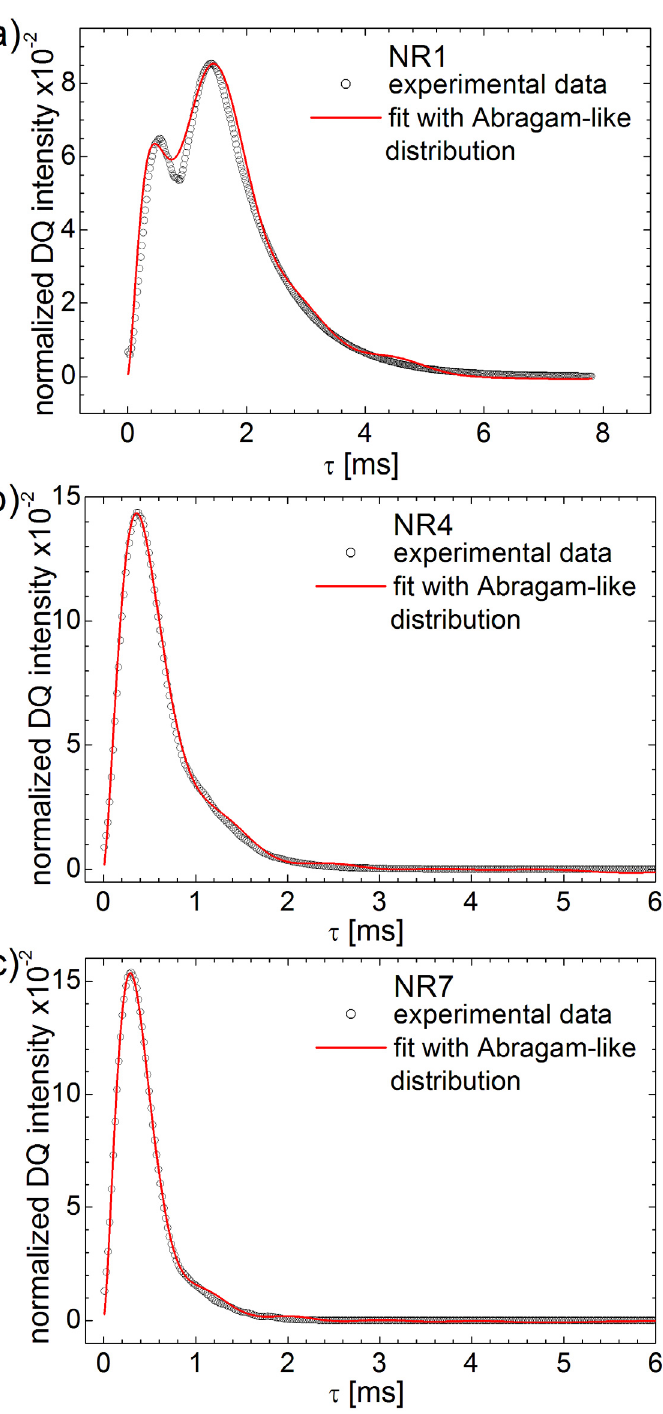
better approximated on the entire time scale (see Figure 13b,c).